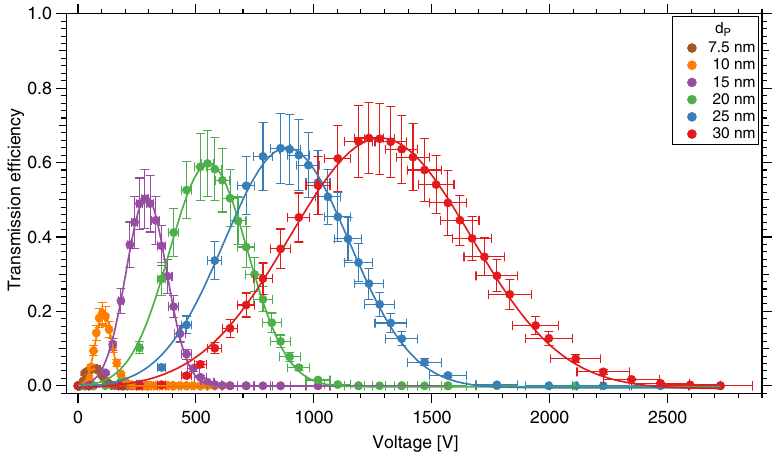
Figure 4. Transmission efficiency of the TD-DMA for different diameters. The DMA unit is characterized in a tandem DMA setup.